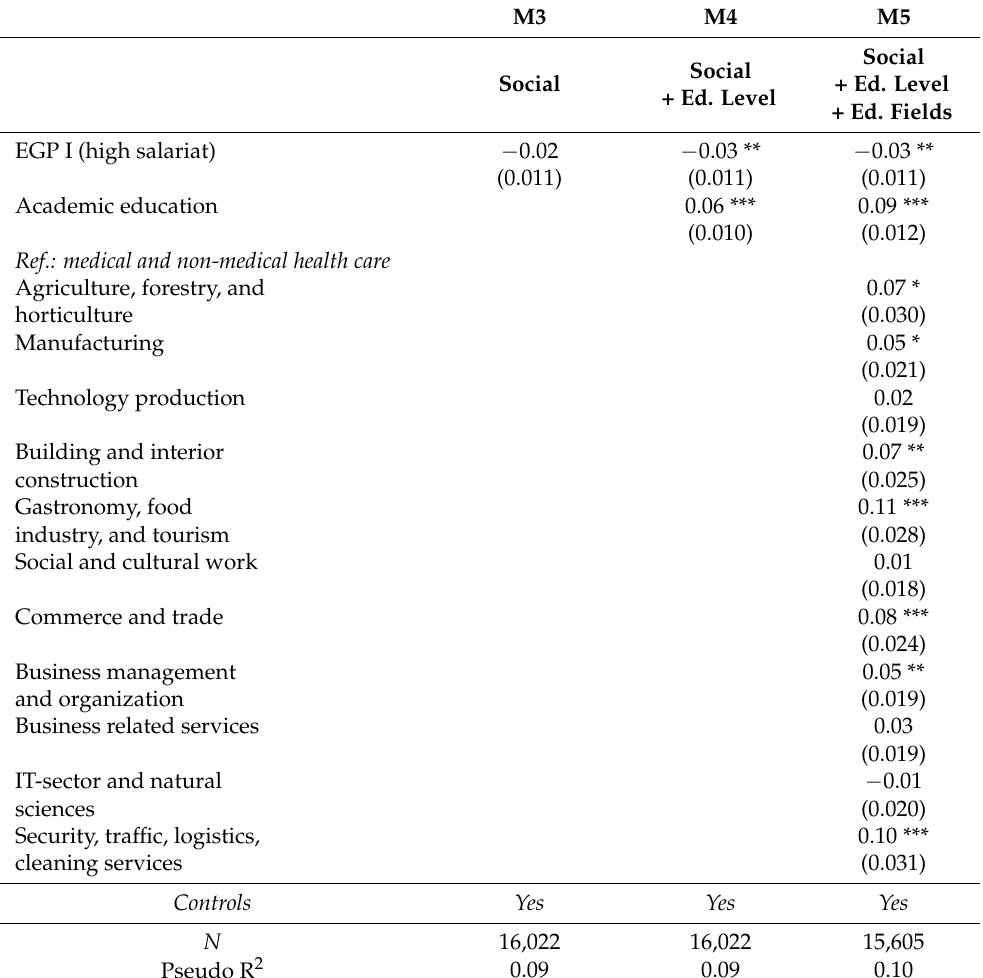
Table 3. Logit regression models of overeducation (subjective indicator) on social background, educational level, and educational fields (AME) 1